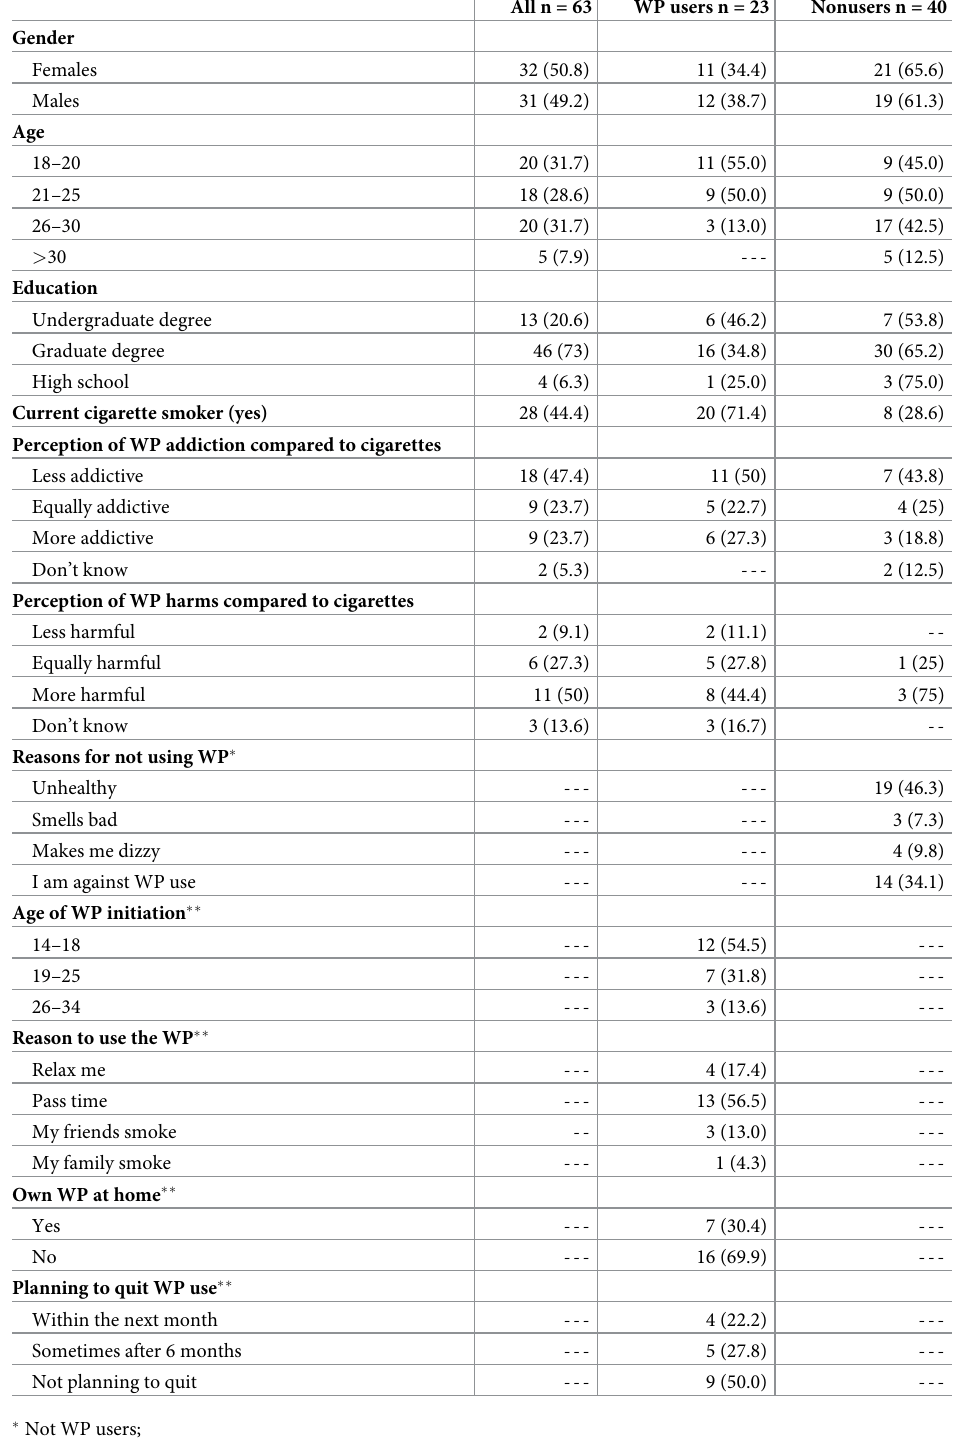
Table 1. Sociodemographic characteristics and waterpipe (WP) use attitudes and perceptions stratified by WP use